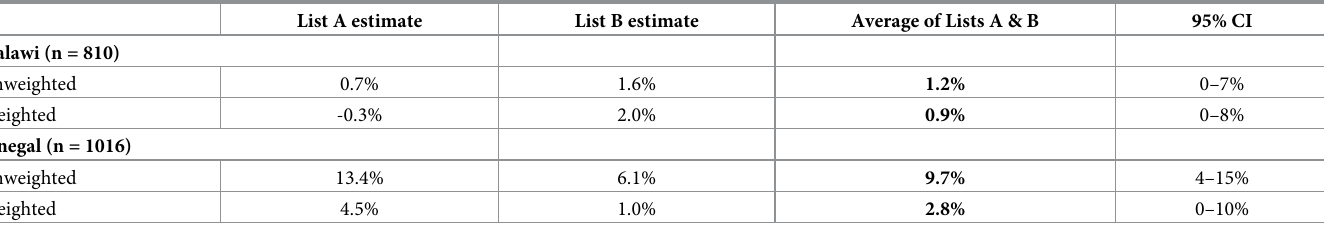
Table 2. List experiment estimates of the percentage of cisgender women of reproductive age who have had an abortion in their lifetime (Lilongwe, Malawi) and in the past five years (Senegal).